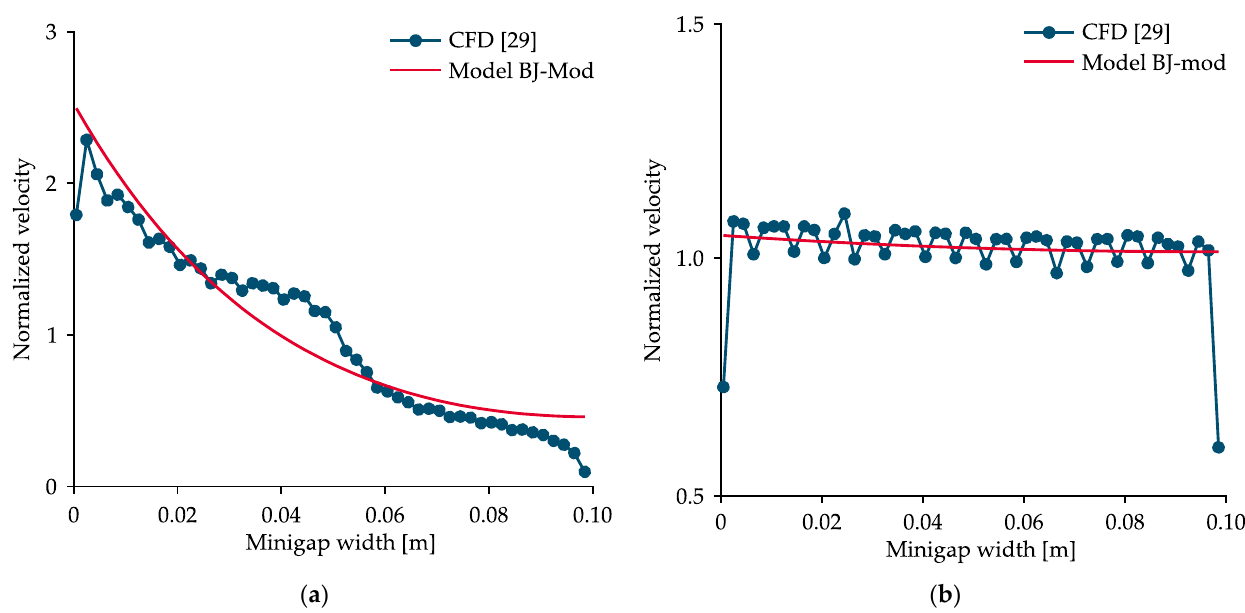
Figure 17. Comparison of the analytical (Model BJ-Mod) and numerical data (taken from the literature): ( a ) the first system configuration (header depth of 1 mm), momentum coefficients for flow in the distributor—1.10, collector—3.10; ( b ) the third system configuration (header depth of 8 mm), momentum coefficients for flow in the distributor—1.00, collector—2.65.